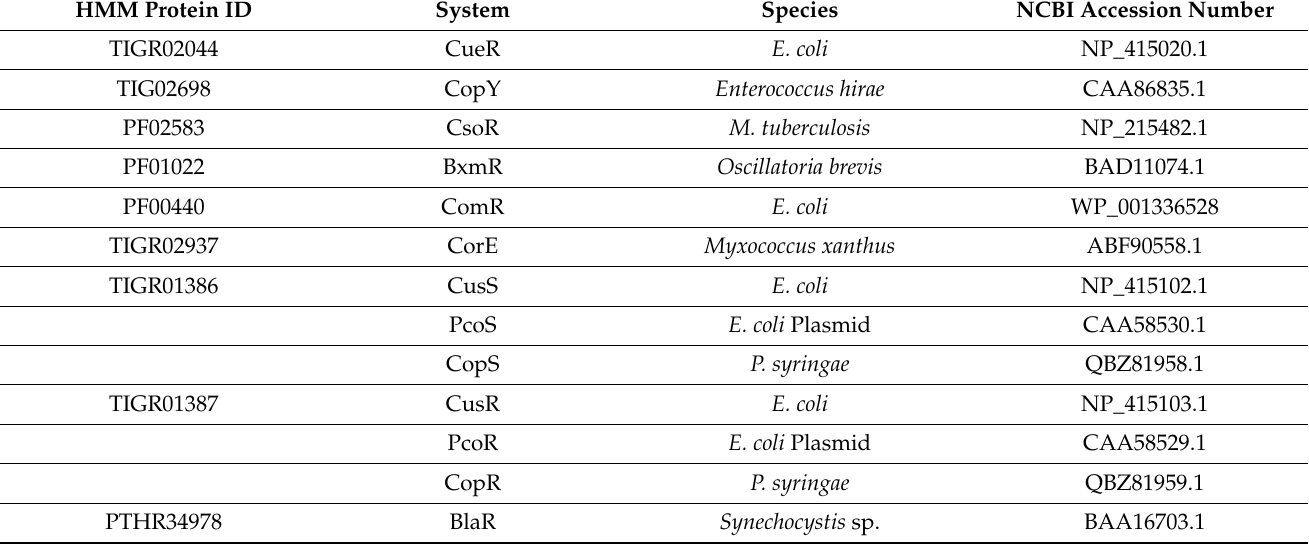
Figure 1. Total number of marine bacteria classified by the phylogenetic system and their source of isolation. X-axis represents isolation source, and Y-axis represents the number of bacterial strains from each source. The colors in the stack plot represent the phylogenetic characterization of the bacteria. Table 1. Copper-associated protein models used for homology search.